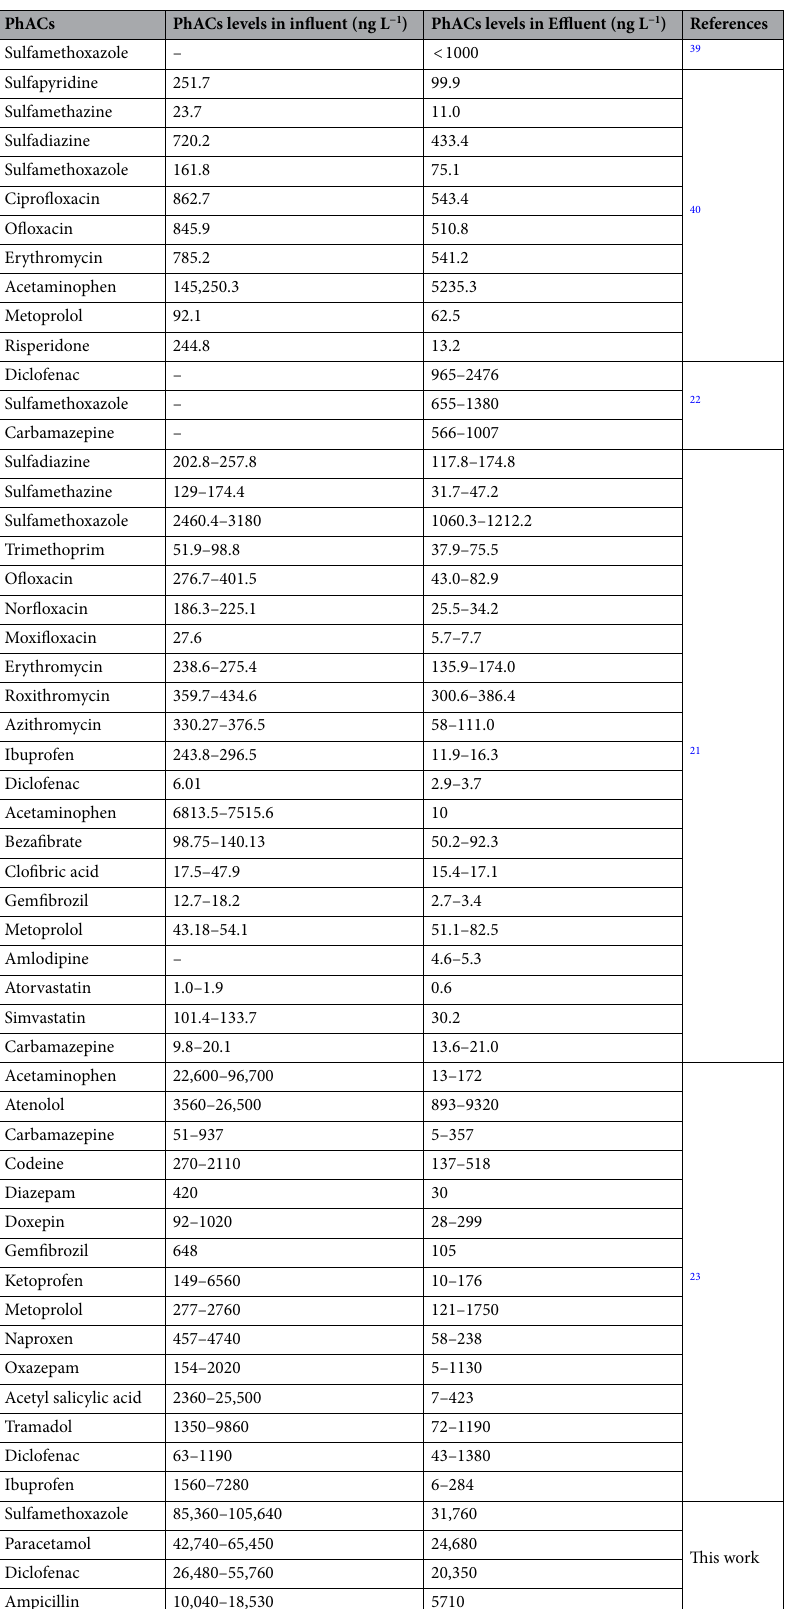
Table 1. International comparison for PhACs levels with current